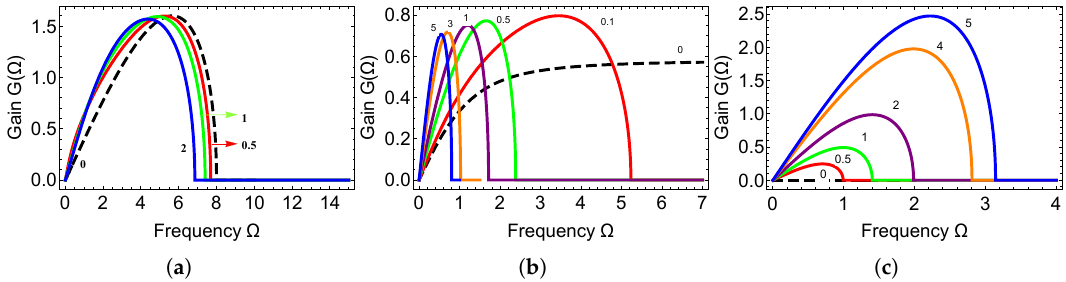
Figure 3. The MI gain spectra in the asymmetric coupler with anomalous GVD ( σ 1 = 1). ( a ) The results for different values of the normalized coupling coefficient, κ . Parameters of the system are P = 2, η = 0.5, α = 0.1, Γ = 2 and ρ = 0.01. ( b ) For different values of the ratio of the GVD coefficients in the cross and bar channels, α , indicated near each curve with P = 1, η = κ = 0.5, Γ = 1 and ρ = 0.01. ( c ) For different values of the ratio of the nonlinearity coefficients in the two cores, Γ , which are indicated near the curves. Other parameters are P = 0.5, η = 0.1, κ = 0.2, α = 1 and ρ =